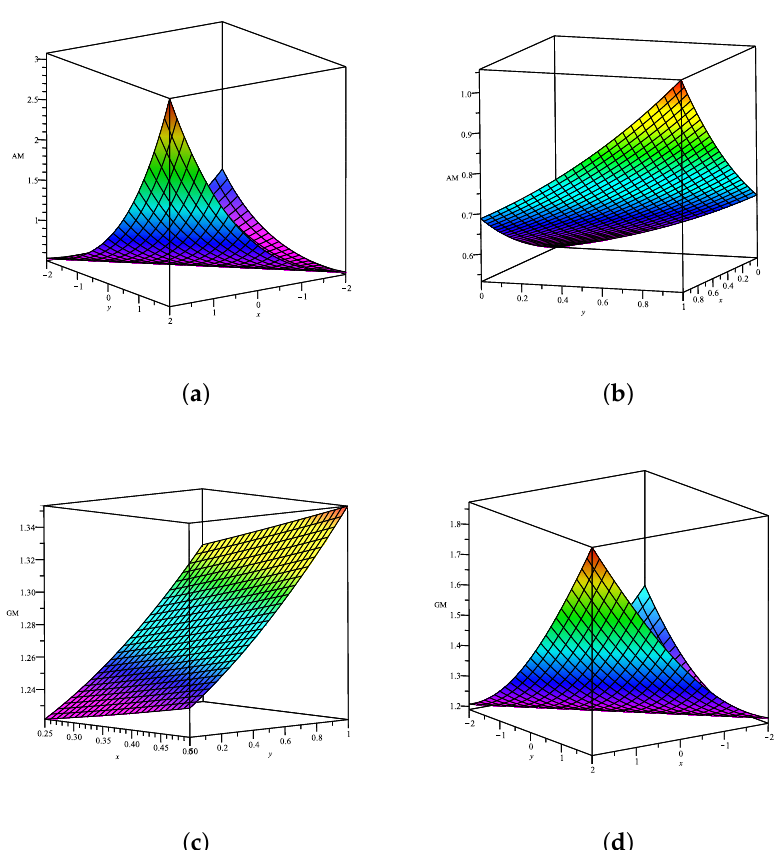
Figure 2. Graphs ( a – d ) are related to the aggregation functions AM and GM for di ff erent values. ( a ) ω 1 ∈ [ − 2,2 ] , ω 2 ∈ [ − 2,2 ] ; ( b ) ω 1 ∈ [ 0,1 ] , ω 2 ∈ [ 0,1 ] ; ( c ) ω 1 = [ 1 ω ∈ [ − 2,2 ] 2